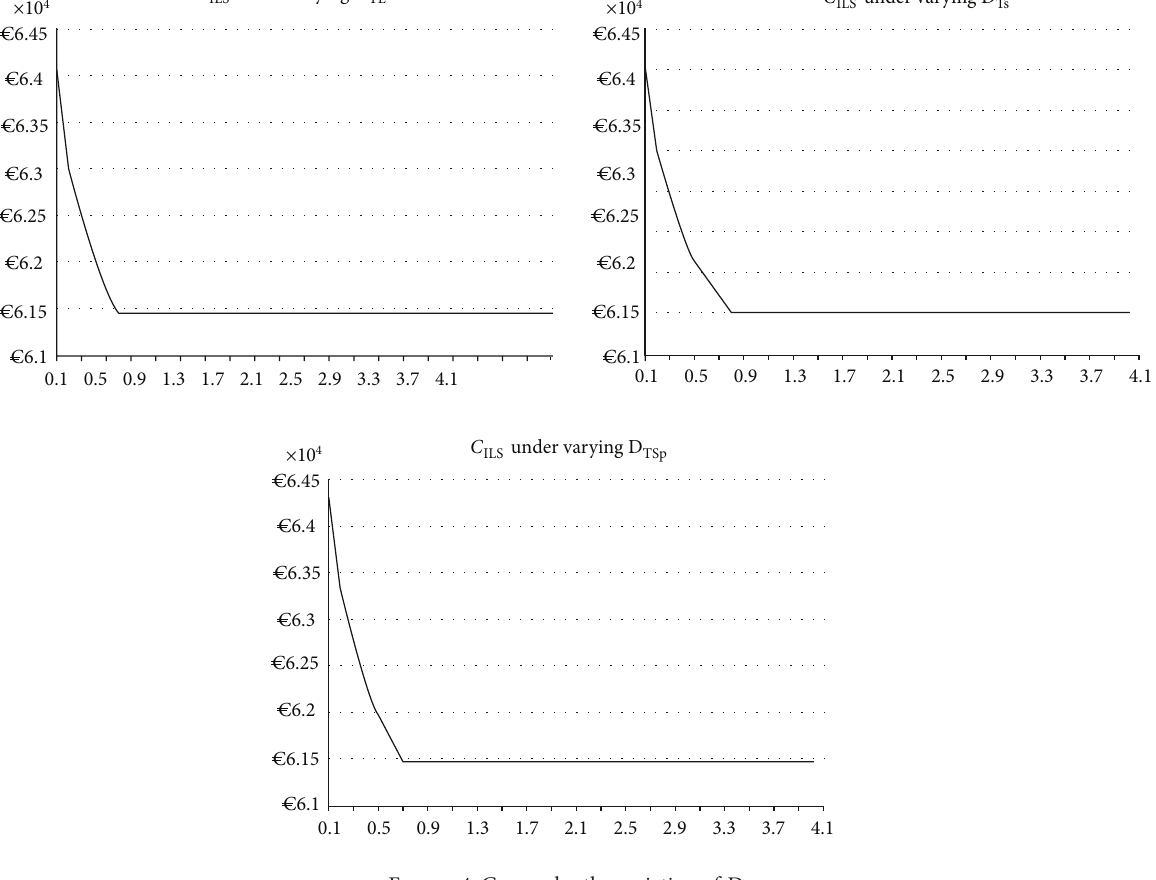
Figure 4: 𝐶 under the variation of D Ts ILS